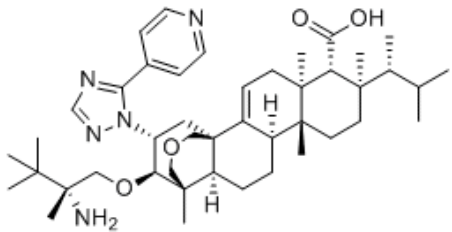
Figure 2. Chemical structure of SCY-078.